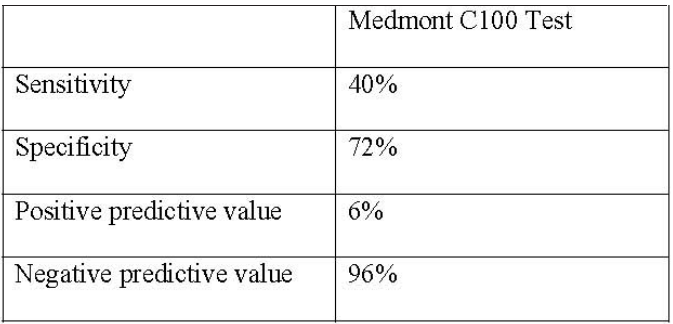
Figure 1. Bar chart of null point responses obtained with the Medmont C100 device and number of subjects per null point. Eighty five (72%) cases out of the 117 subjects gave a null point in the region between 1.2 to –1.9 (normal region), and 33 cases (28%) were in the protan region; – 2 to – 3.2 (no null point setting above –3.2). Table 3. The sensitivity/specificity and positive/negative pre- dictive values of Medmont C100 test using the screening mode of the Anomaloscope as the standard test for comparison as shown in Table 2. pass/fail responses out of the 117